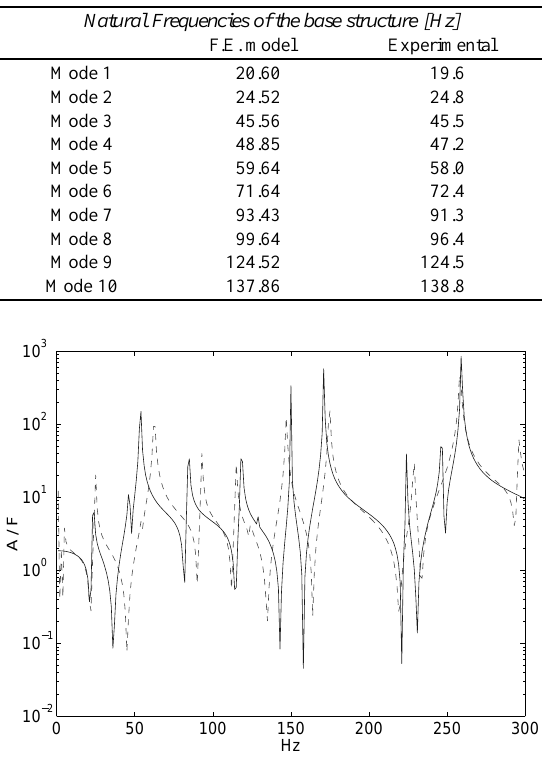
Fig. 6. Frame-plate coupling. Translation/force FRFs: complete FE model (–); coupling by omitting the rotational DoFs (- - -) and using test data.